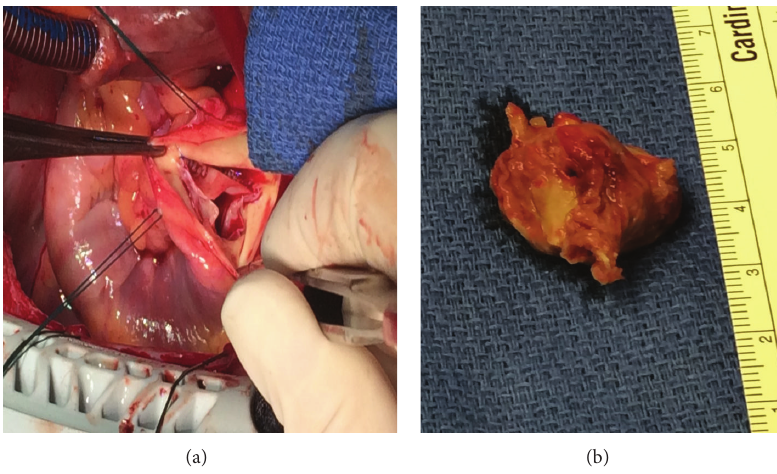
Figure 3: The pulmonic valve in vivo (a) and the excised valve leaflet